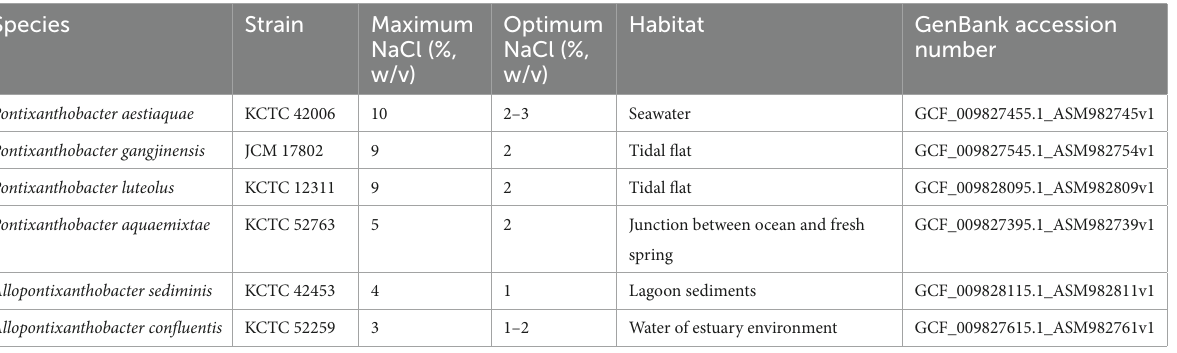
TABLE 1 Strains used for analysis in this